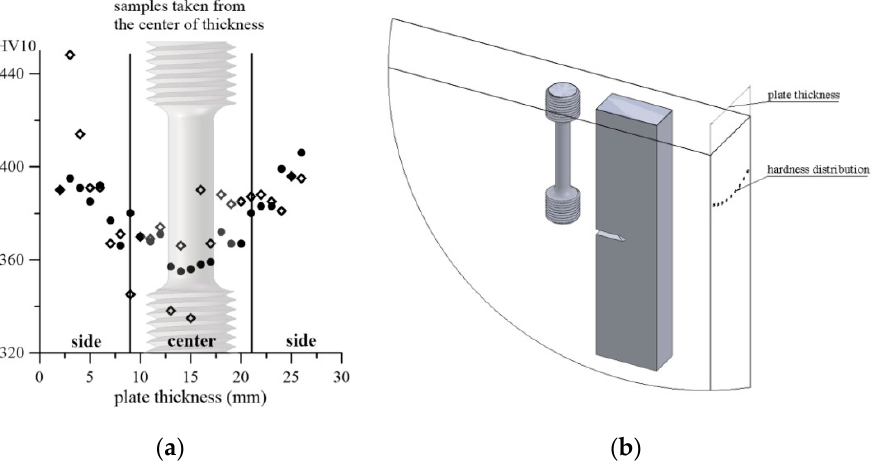
Figure 3. ( a ) Hardness distribution through the plate thickness; ( b ) the scheme of cutting out a